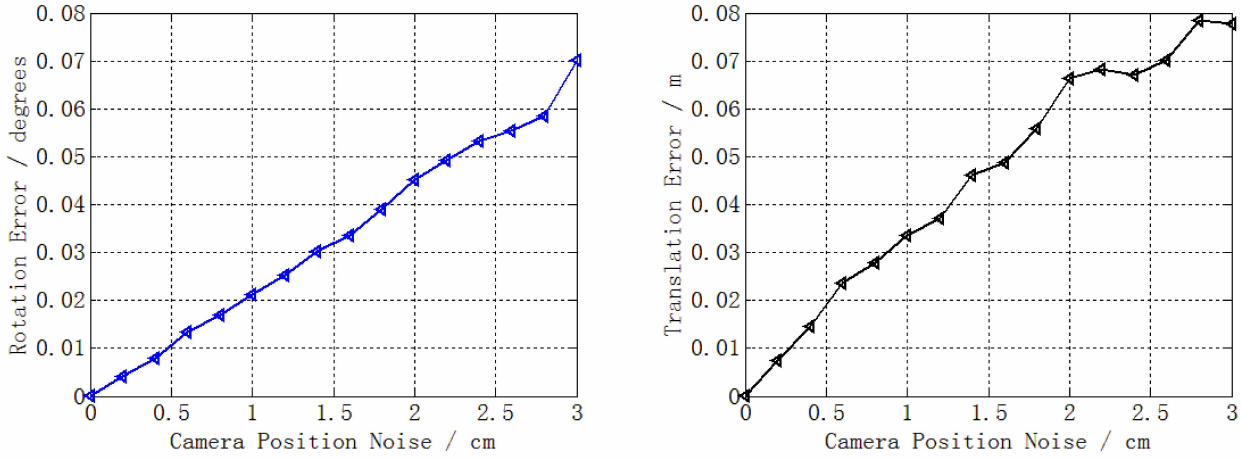
Figure 6. Rotation error ( left ) and translation error ( right